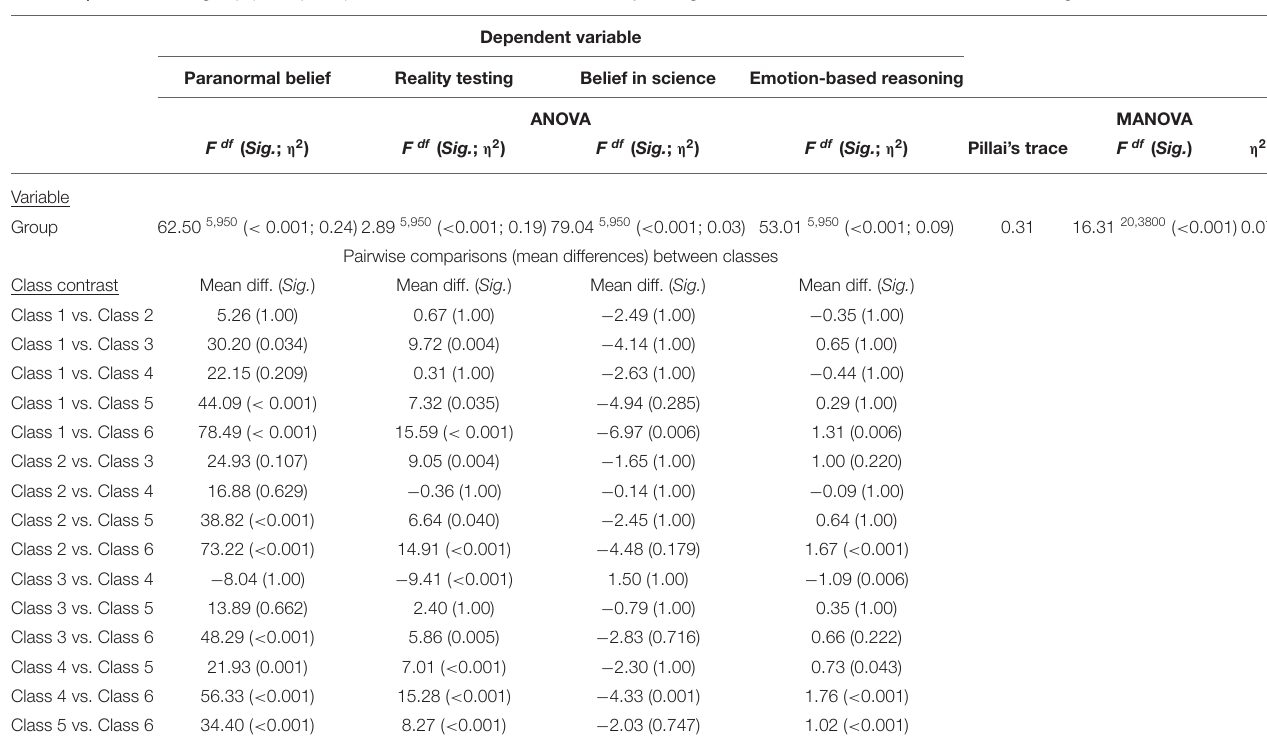
TABLE 4 | The effects of group (latent profile) in relation to Paranormal Belief, Reality Testing, Belief in Science, and Emotion-based